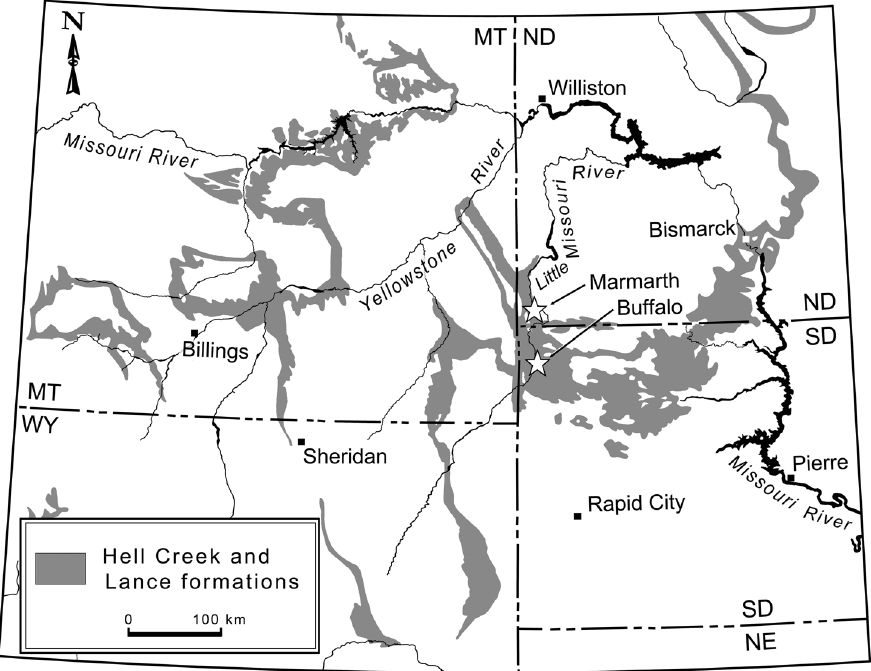
Figure 1. Exposures of the Upper Cretaceous Hell Creek and Lance formations in western North America. Localities that have yielded specimens of Anzu wyliei gen. et sp. nov. are marked by white stars. Map modified from [55]. Scale bar =100 km.